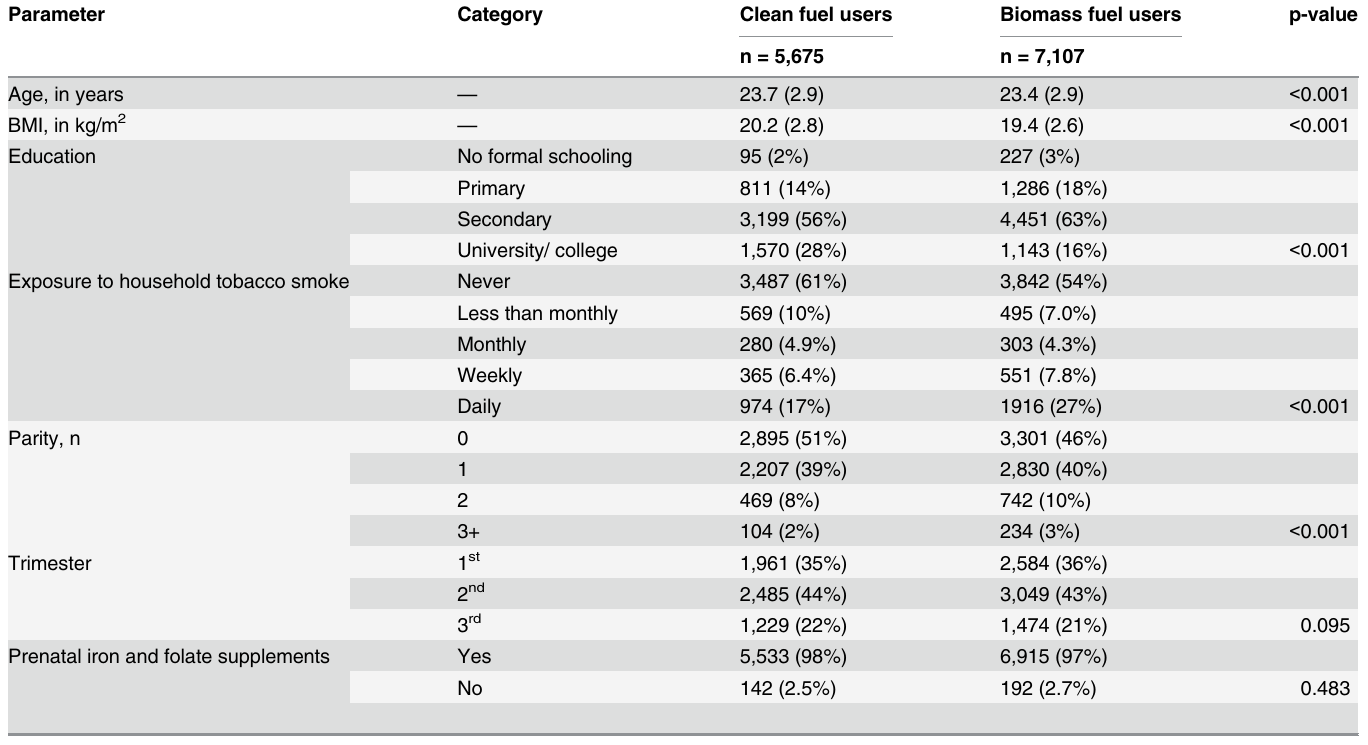
Table 1. Characteristics of participants. Data expressed as mean (SD) or frequency